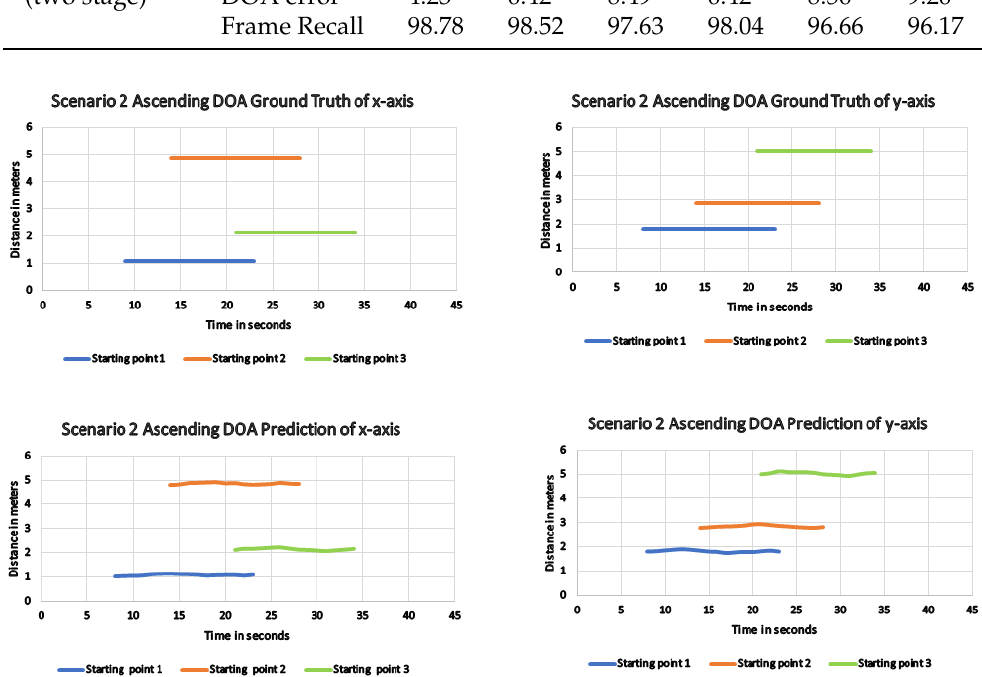
Figure 15. DOA result for the proposed method showing the difference in the actual and predicted x, y coordinates of scenario 2 ascending direction.